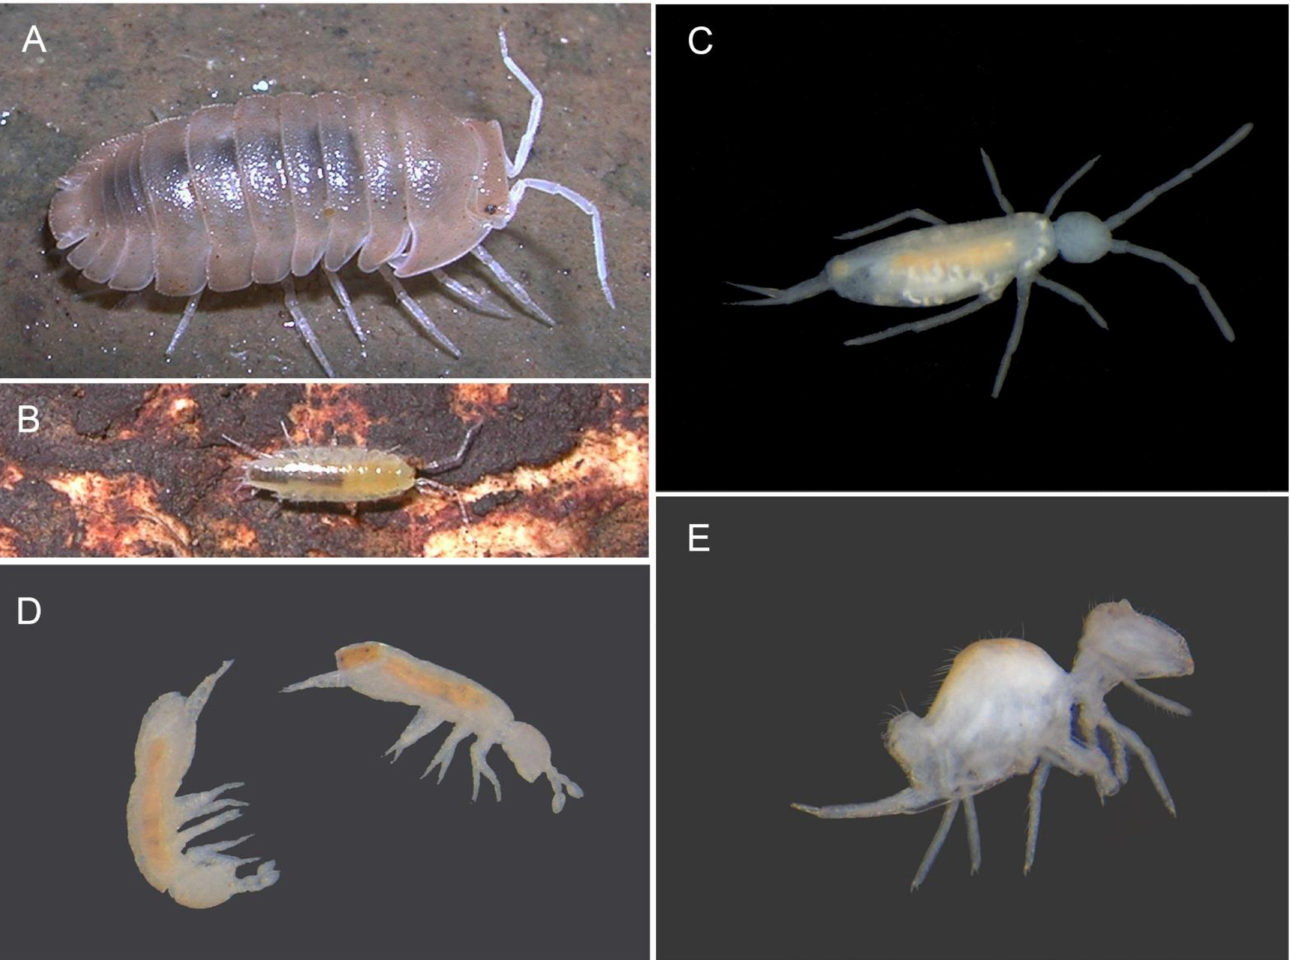
Figure 7. ( A ) Venezillo sp. from Leang Saripa; ( B ) Papuaphiloscia sp. from Leang Saripa; ( C ) Pseudosinella maros from Gua Lumpur; ( D ) Oncopodura sp. from Gua Tanette; ( E ) Pararrhopalites sp. from Gua Tanette. Reproduced with permission from Louis